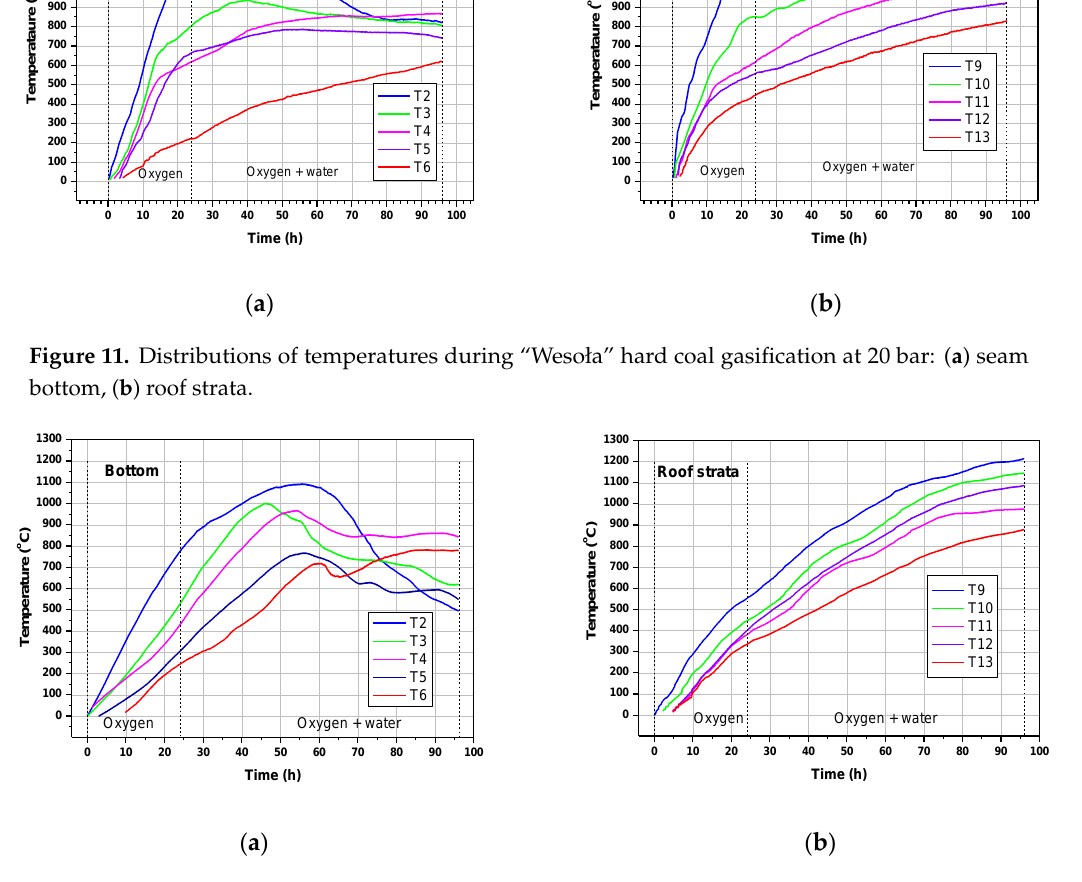
Figure 12. Distributions of temperatures during “Six Feet” semi-anthracite gasification at 40 bar: ( a ) seam bottom, ( b ) roof strata.